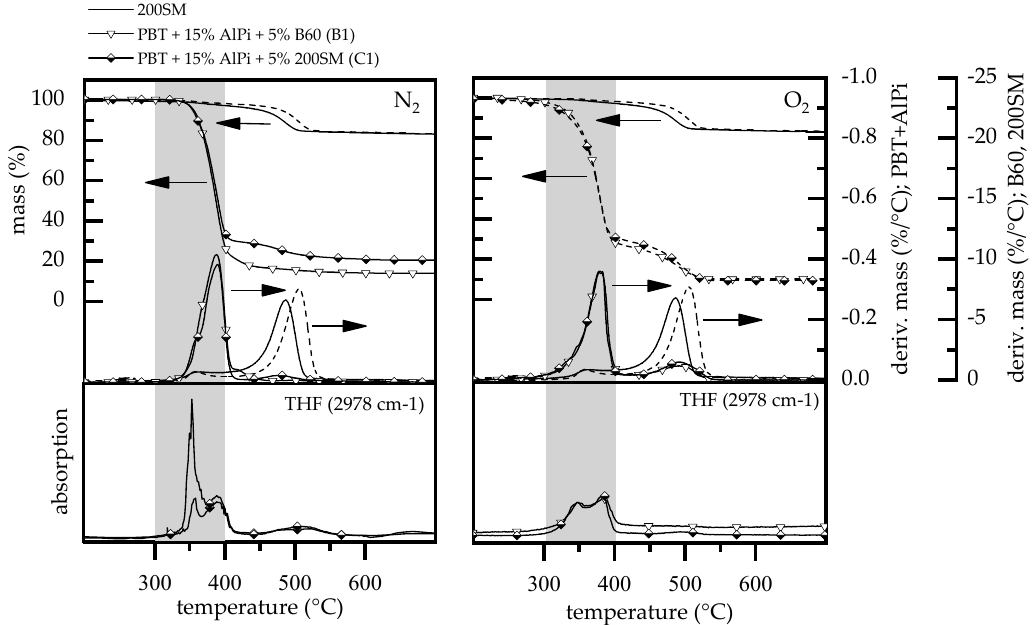
Figure 7. Comparison of TGA curves of pure boehmite, PBT + 15 wt.% AlPi / 5 wt.% boehmite mixtures and FTIR spectra for tetrahydrofuran (THF) over time. Heating rate conducted: 5 K / min. THF are highly flammable gases. Therefore, the early release into the gas phase for mixtures containing smaller 200SM boehmite particles explain the deviating results in LOI